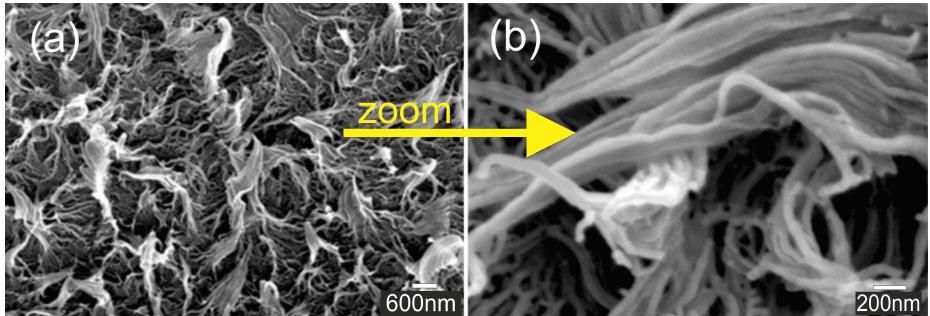
Figure 15. ( a , b ) Coating spherulite structure at different